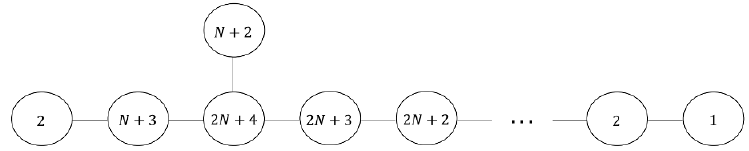
Figure 1. The 3 d mirror dual of the SCFT one gets by compacti(cid:12)cation of the 6 d